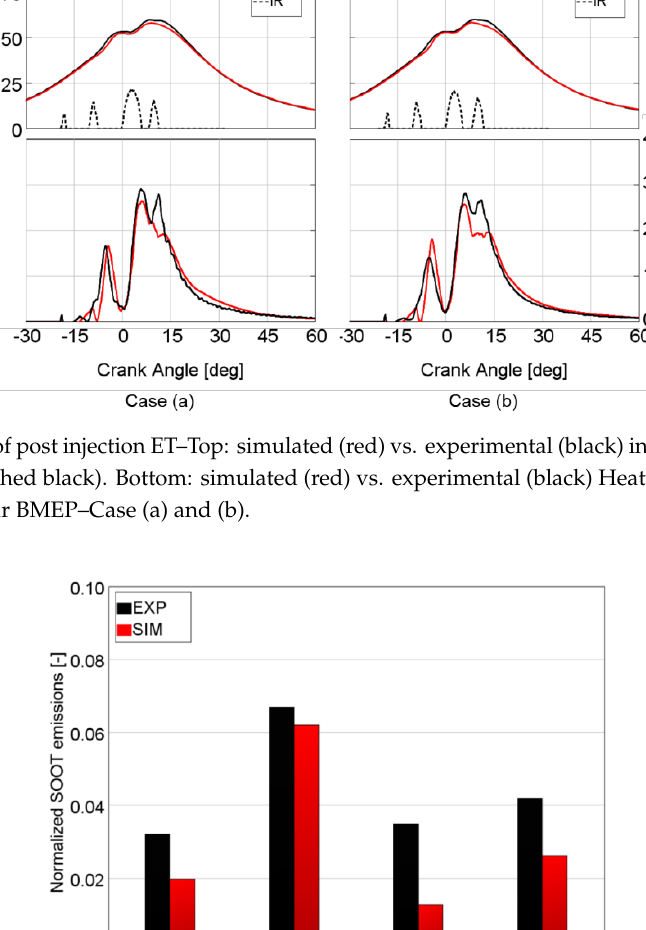
Figure 16. Effect of post injection ET – Top: simulated (red) vs experimental (black) in-cylinder pressure, injection rate (dashed black). Bottom: simulated (red) vs experimental (black) Heat Release Rate. WP: 1500 rpm x 5.0 bar BMEP – Case a) and b).